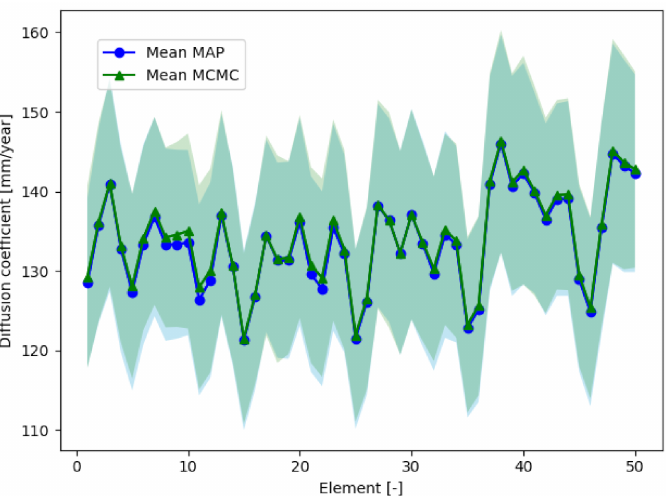
Figure 3. Posterior distributions of the diffusion coefficient based on strain mode shapes at all elements. The dashed areas correspond to the 68% confidence